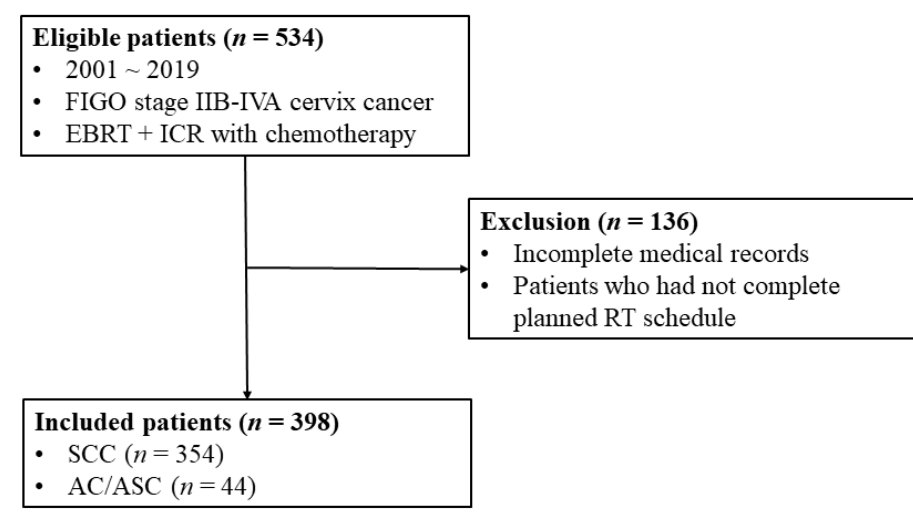
Figure 1. Inclusion and exclusion criteria for the study population. FIGO, International Federation of Gynecology and Obstetrics; EBRT, external beam radiotherapy; ICR, intracavitary radiotherapy; RT, radiation therapy; SCC, squamous cell carcinoma; AC, adenocarcinoma; ASC, adenosquamous carcinoma. Table 1. Clinicopathological characteristics of patients with SCC or AC / ASC.